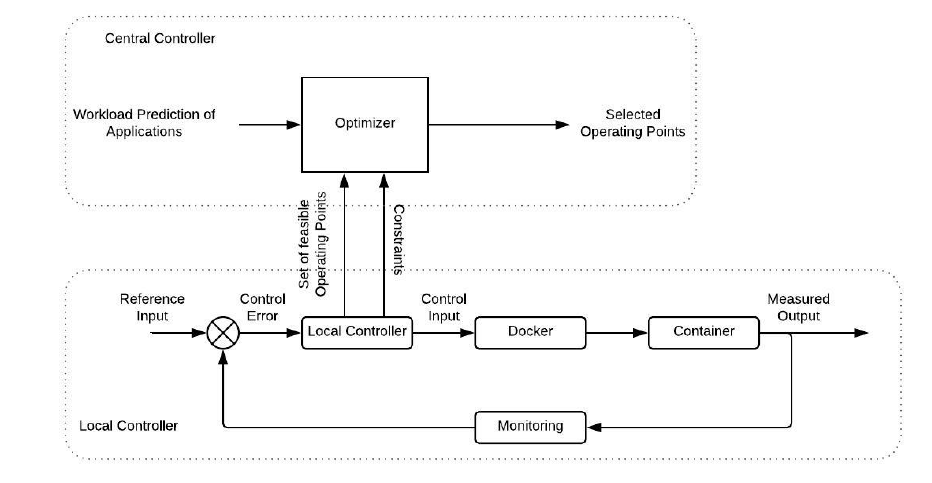
Figure 4. Feedback control system in Vertical